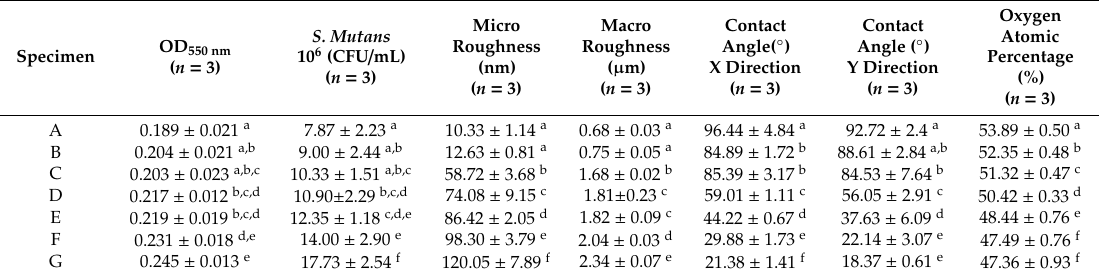
Table 2. The values of the OD, CFU, roughness, contact angles and oxygen content of the present alloys, specimens